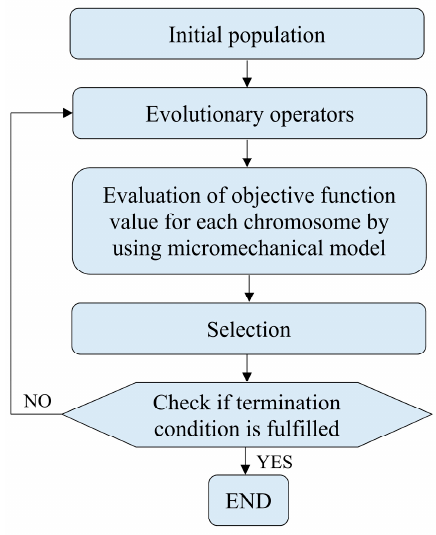
Figure 2. Scheme of evolutionary algorithm used for identification.